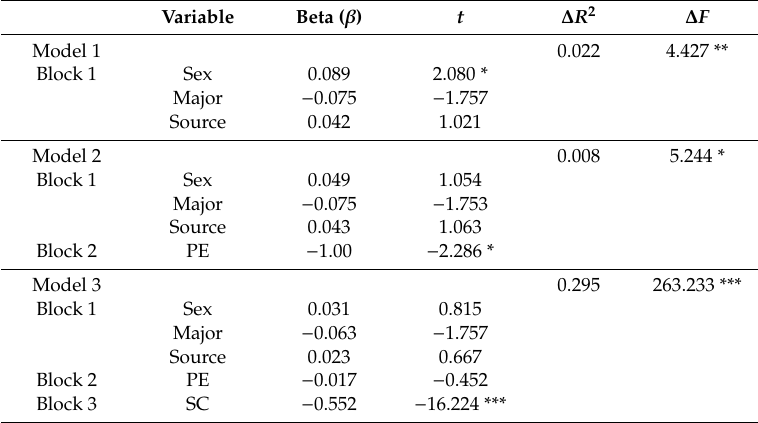
Table 3. Demographic indicators, PE, and SC as predictors of